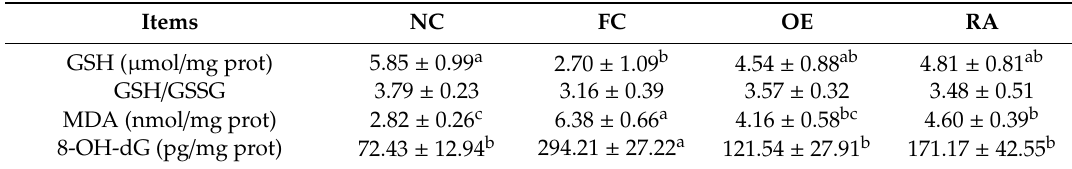
Table 1. Jejunal antioxidant parameters in mice fed a normal diet (NC), high-fat diet (FC), or high-fat diet with OE (OE) or rosmarinic acid